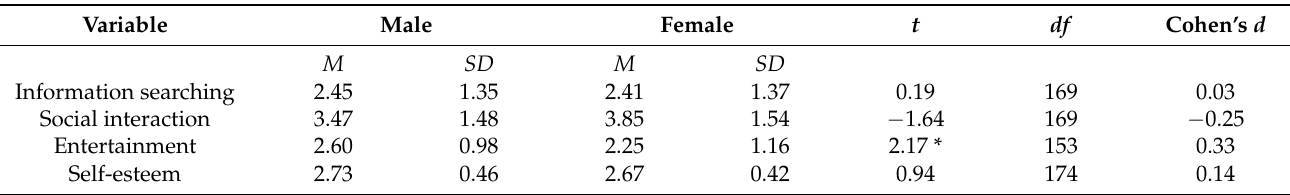
Table 3. Gender differences among all